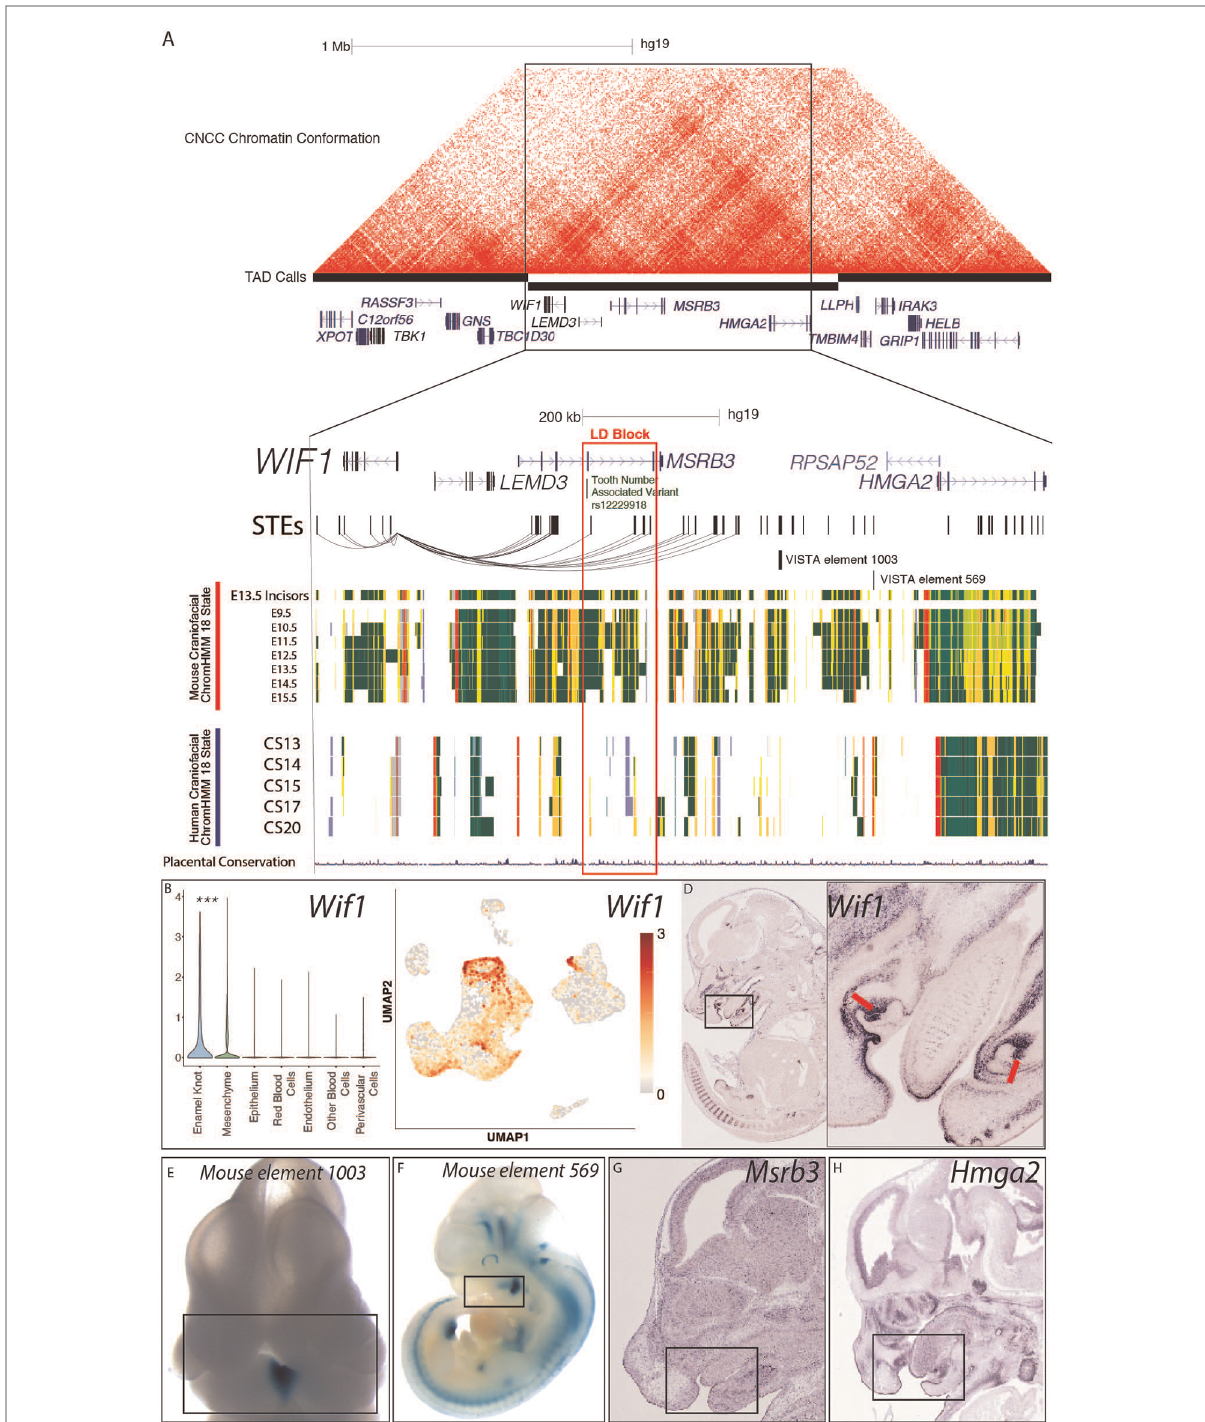
FIGURE 4 WIF1 locus is a candidate for human odontogenic phenotypes. ( A ) Visualization of the locus surrounding rs12229918 (chr5:134509987, hg19) and nearby fi ne-mapped variants associated with decreased tooth number and delayed tooth eruption by (83). Chromatin conformation heatmap demonstrated using HiC from a human CNCC culture line, from (109). STEs are shown as hg19 coordinates. Mouse craniofacial 18 state segmentations were generated as described in Methods from data from ENCODE (56); these rows are from mm10 coordinates of the orthologous locus containing the orthologous genes. Human craniofacial 18 state segmentations were obtained from (40). ( B,C ) Single cell transcriptomic analysis demonstrated the PEK-speci fi c expression of Wif1 in the E14 mouse molar; p <0.05, Wilcoxon test. ( D – G ) In situ hybridization images of Wif1 , Hmga2 , and Msrb3 were obtained from GenePaint http://genepaint.org/viewer/setInfo/MH772, https://genepaint. org/viewer/setInfo/EN837, and https://genepaint.org/viewer/setInfo/EH300, respectively (75). Enhancer assay images were obtained from VISTA